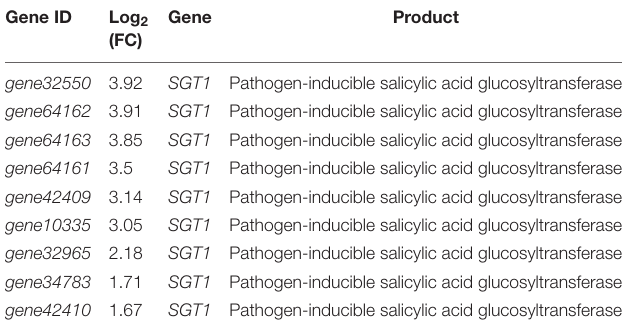
TABLE 3 | Effects of strain YC136 on salicylic acid signaling pathway in tobacco.